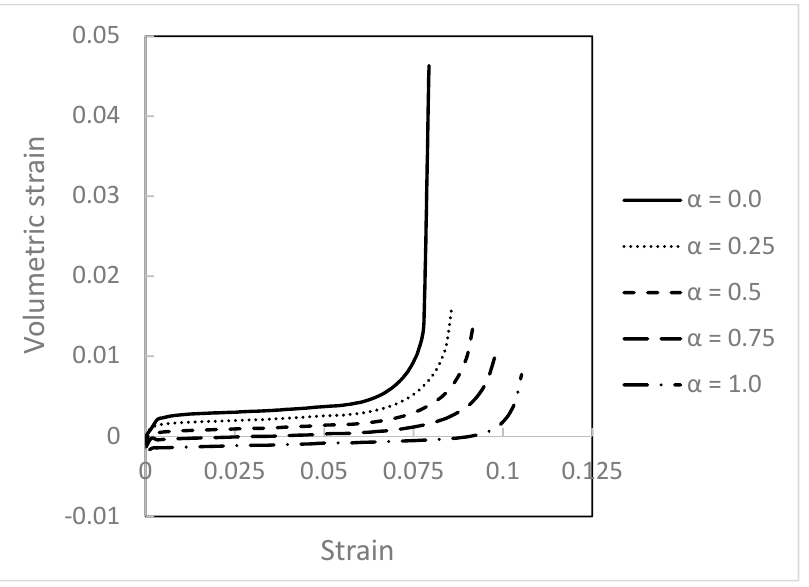
Figure 8. Effect of superimposed hydrostatic pressure on volumetric strain at the center of the specimen.